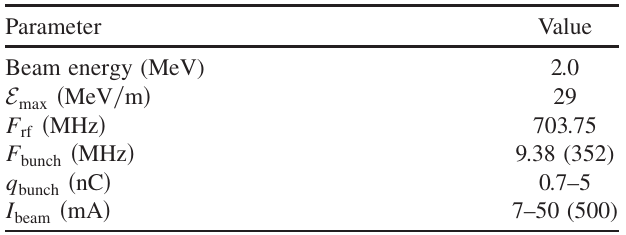
TABLE I. Parameters of the BNL 1 = 2 -cell SRF gun with nominal values. These numbers are used in the paper. The numbers in parentheses show values after a possible laser